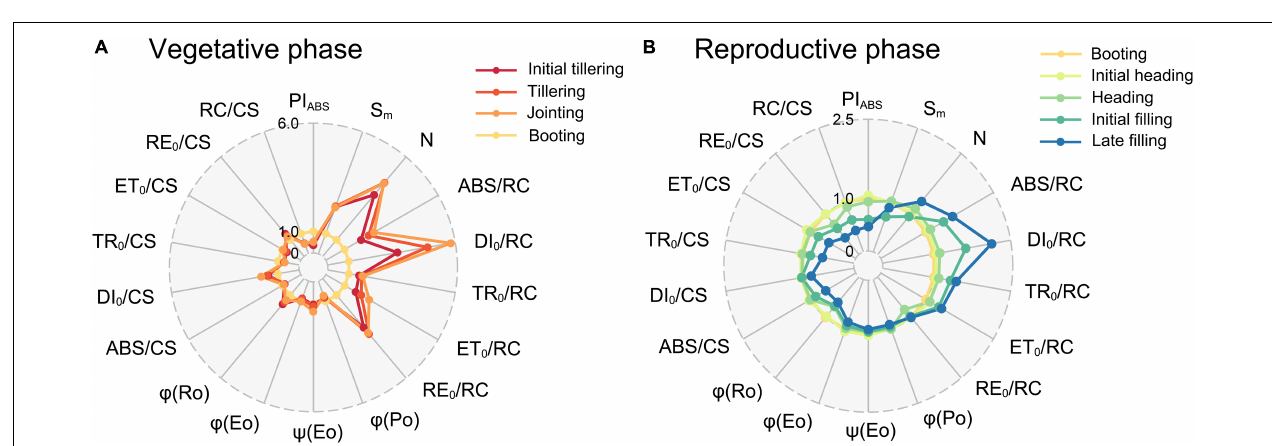
FIGURE 5 | Radar plots of functional parameters in the (A) vegetative and (B) reproductive phases. The mean value of all parameters at the booting (R1) was considered as the control (each parameter equals 1, denoted by the red circle), and parameters of leaves at the other stages were expressed by the fraction of the average value at the booting (R1). Individual data points are the mean value of four biological replicates.